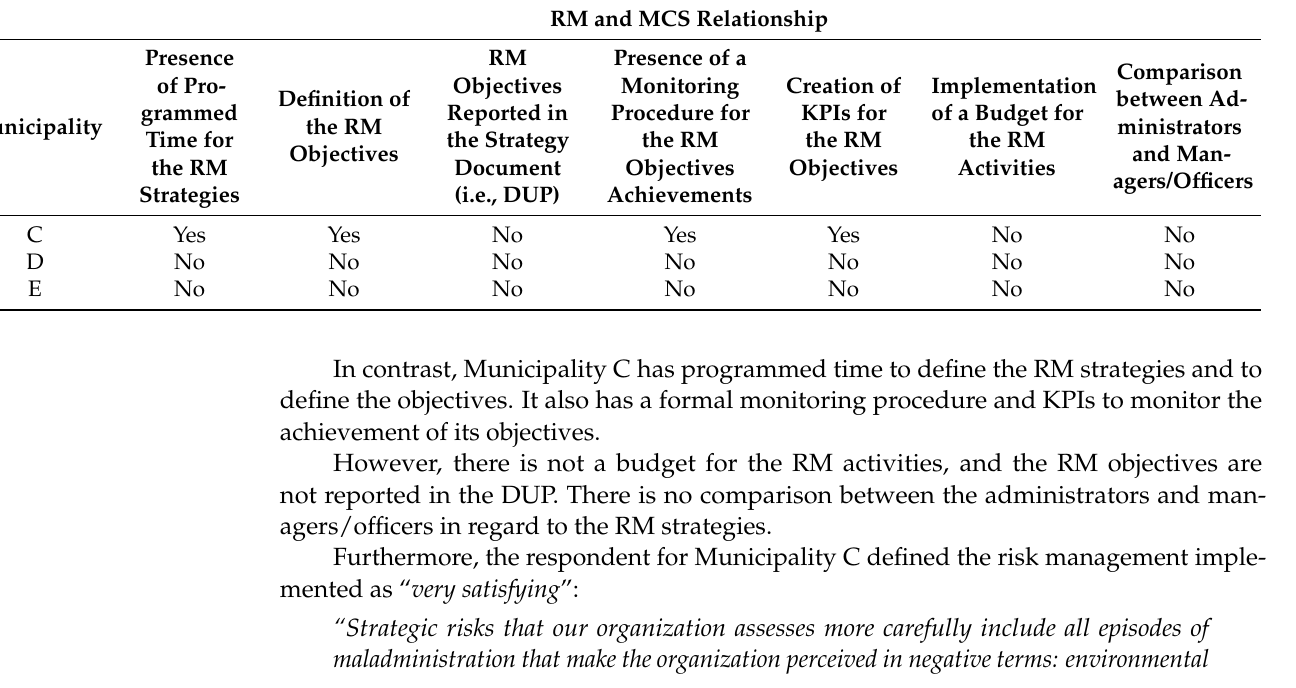
Table 6. Responses about risk management and the management control system relationship for Municipalities C, D and